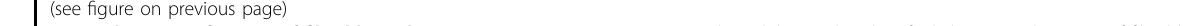
Fig. 4 Changes in features of fi broblasts during tumor progression. a UMAP plot exhibiting the identi fi ed clusters and sources of fi broblast in the STRT and 10× datasets. b Histogram showing cell type percentage of fi broblasts from different sources in the STRT and 10× datasets. Pie plot showing fi broblast source percentages in different cell types. c Dot plots presenting the normalized expression levels of corresponding markers of each fi broblast cluster in the STRT dataset. d Heatmap showing expression of marker genes of fi broblasts from tumor and normal tissues in the STRT dataset. e Representative IHC staining of RCN3 in adjacent normal and primary tumor tissues (original magni fi cation 100×). The rows of the paired normal and tumor samples are from the same patients, and three individual patients are listed. Scale bar, 100 μ m. f Violin plot exhibiting expression of continuously increasing markers during tumor progression in the STRT dataset. g Dot plot showing expression of interaction pairs in fi broblast and epithelial cell pairs from different